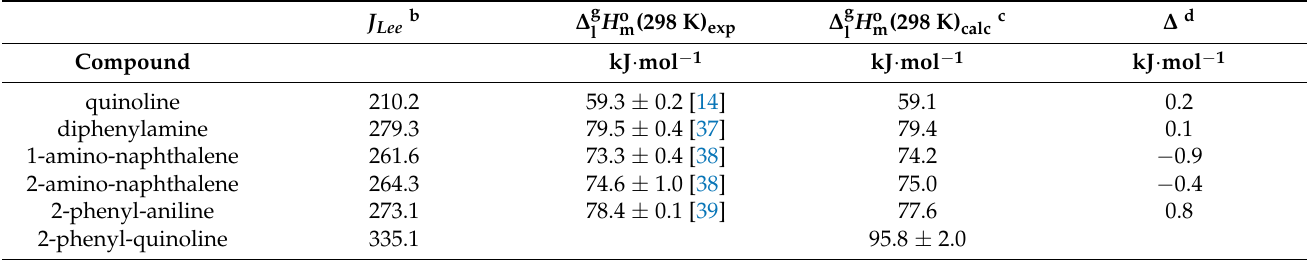
Table 6. Correlation of vaporization enthalpies, ∆ g column a .